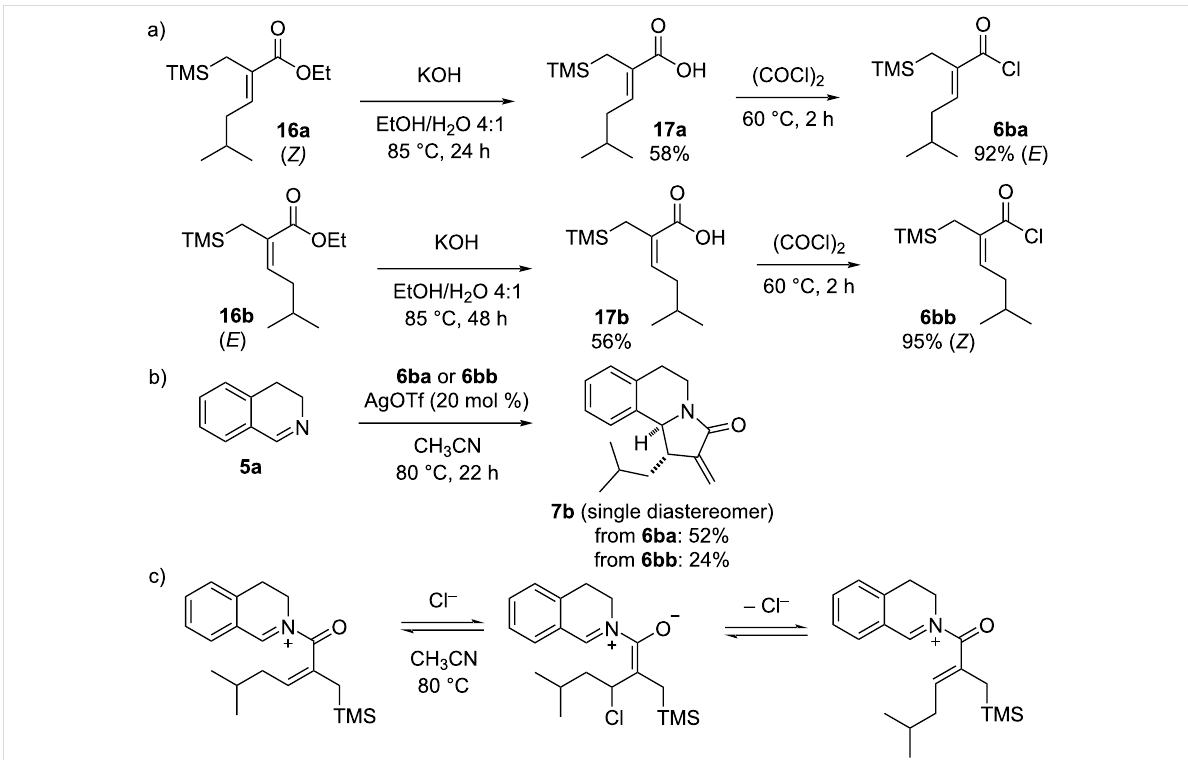
Scheme 9: (a) Preparation of acyl chlorides 6ba and 6bb in diastereomerically pure forms, (b) aza-Nazarov cyclization of ( E )- 6ba and ( Z )- 6bb under the optimized reaction conditions and (c) tentative mechanism for the olefin E – Z